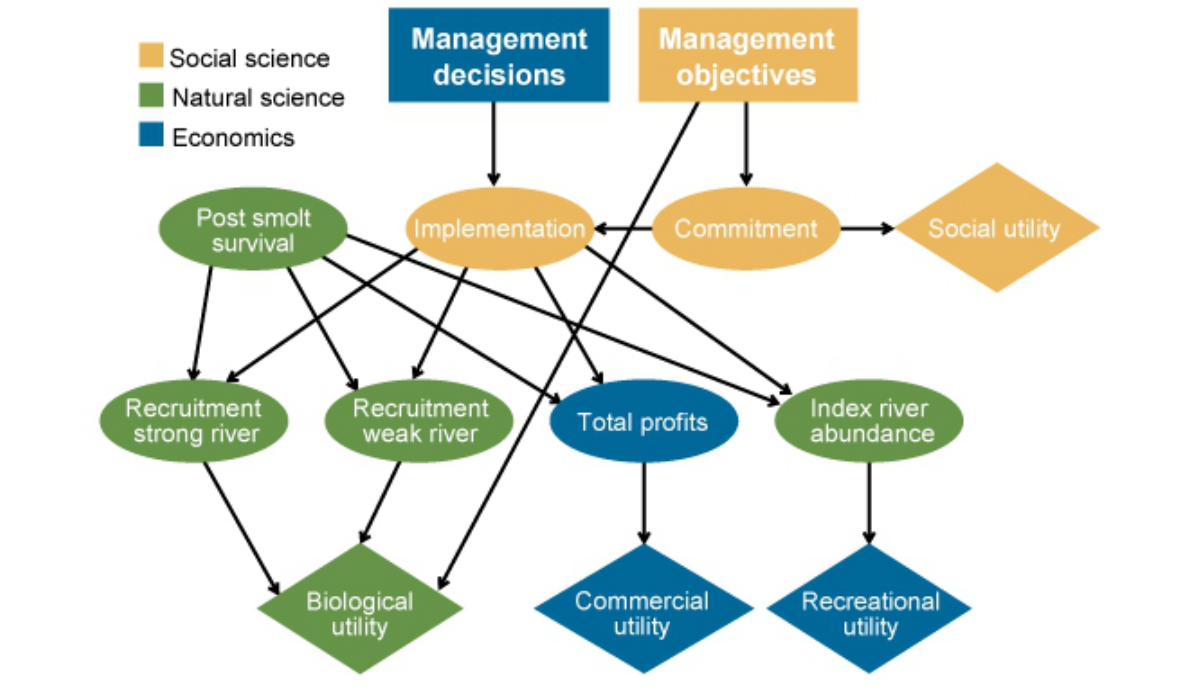
Fig. 1 . The integrated Bayesian belief network (BBN) model, modified from the model published by Levontin et al. (2011). Parts produced by different disciplines are indicated by different colors. The model allows examination of how the results of the bioeconomic model (regarding optimal management) would change if the effect of the implementation uncertainty (resulting from fishers’ commitment to alternative management objectives) were taken into account in a quantitative manner. The model also makes it possible to compare different management objectives and options in terms of biological, commercial, recreational, and social utility (Levontin et al.